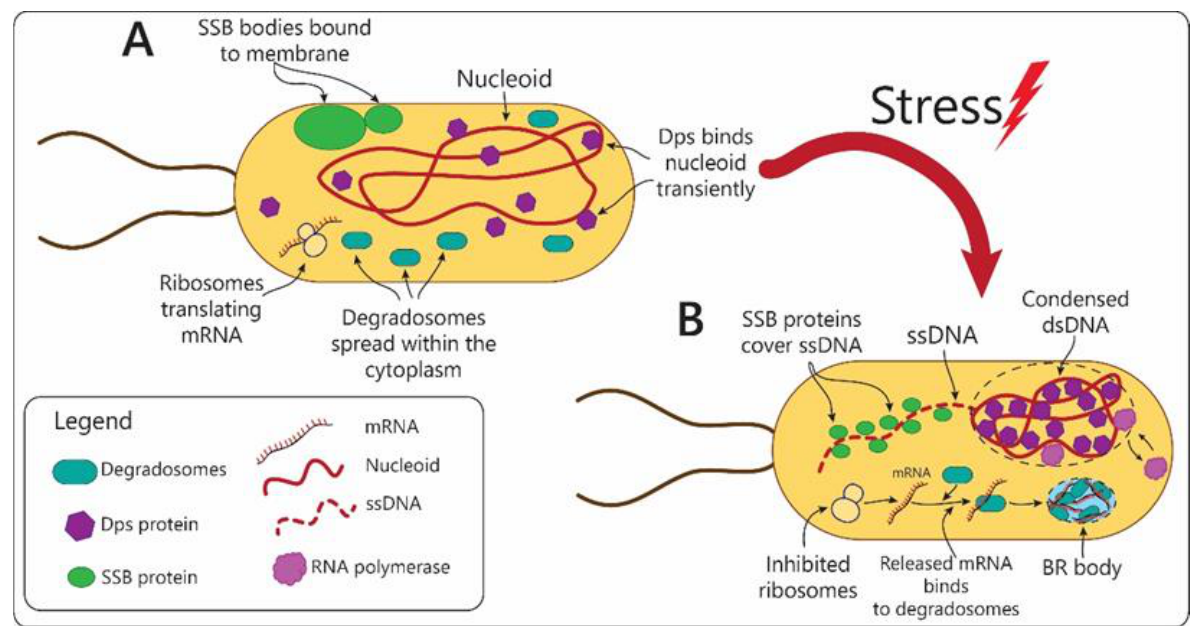
Figure 5. Illustration of changes happening in SSB condensates, Dps condensates, and BR bodies formed by RNaseE degradosomes during stress response in prokaryotes. ( A ) Illustration of un- stressed bacterial cell. SSB proteins are sequestered into droplet-like SSB condensates bound to membrane. Dps protein before stress transiently binds to bacterial genome but unable to reach suffi- cient concentrations to trigger condensate assembly. RNase E tetramers bound to protein partners (degradosomes) are spread throughout the cytoplasm. RNA transcription and translation proceed normally. ( B ) Illustration of cell upon the onset of stress. SSB condensates are disintegrated upon accumulation of single-stranded DNA (ssDNA) and free SSB complexes bind to ssDNA protecting it. Dps complexes heavily cover nucleoid driving the formation of phase separated organelle, which remains permeable for RNA polymerase enzyme. Stress leads to inhibition of translation and release of mRNA from polyribosomes. Untranslated mRNA binds to degradosomes complexes leading to phase separation and assembly of BR bodies.